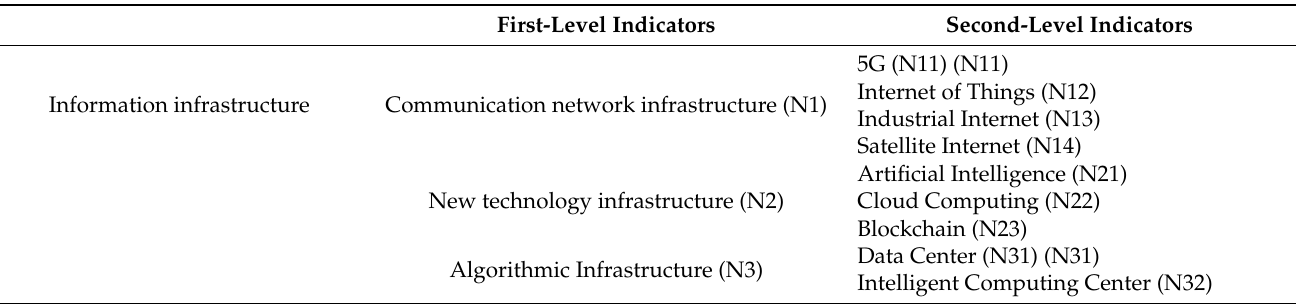
Table 1. Evaluation index system of development level of information